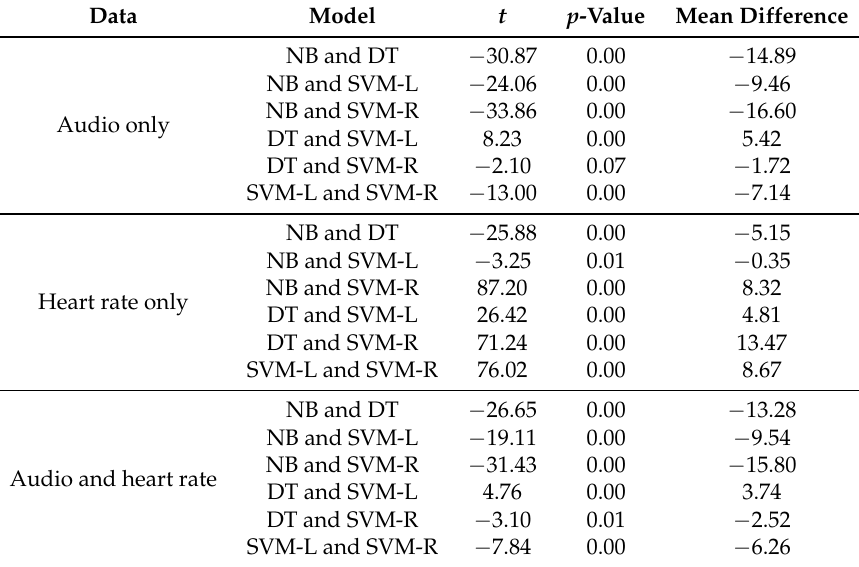
Table 6. Results of t -test for accuracies obtained by performing 10-fold cross validation according to the utilized models and